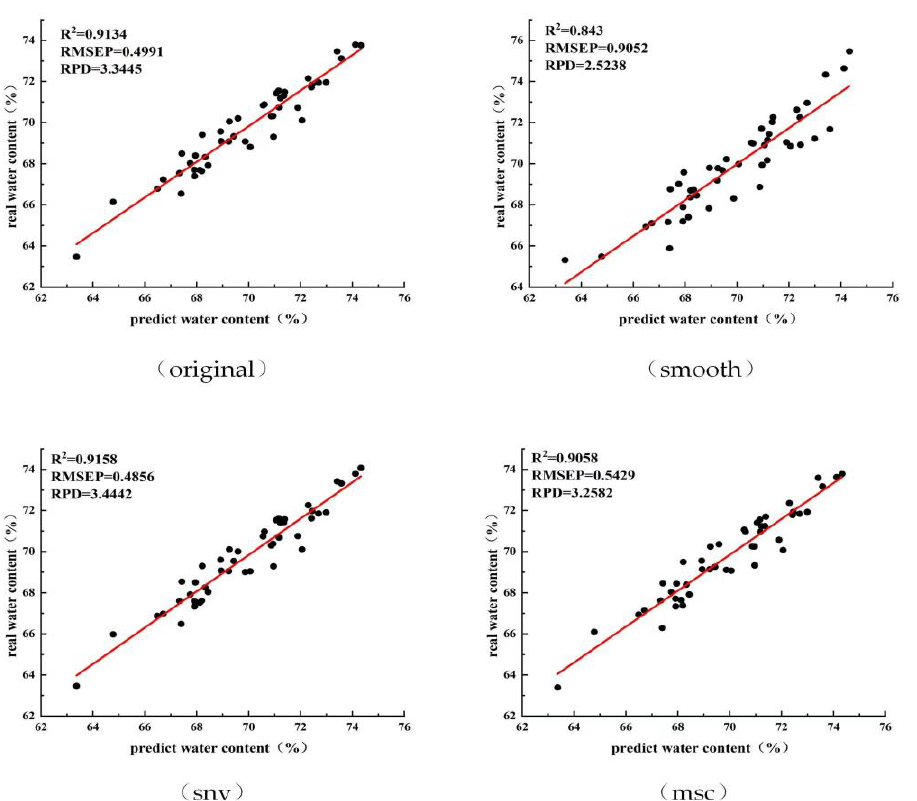
Figure 5. Correlation analysis of the effect of different pre-processing methods on prediction accu- racy.